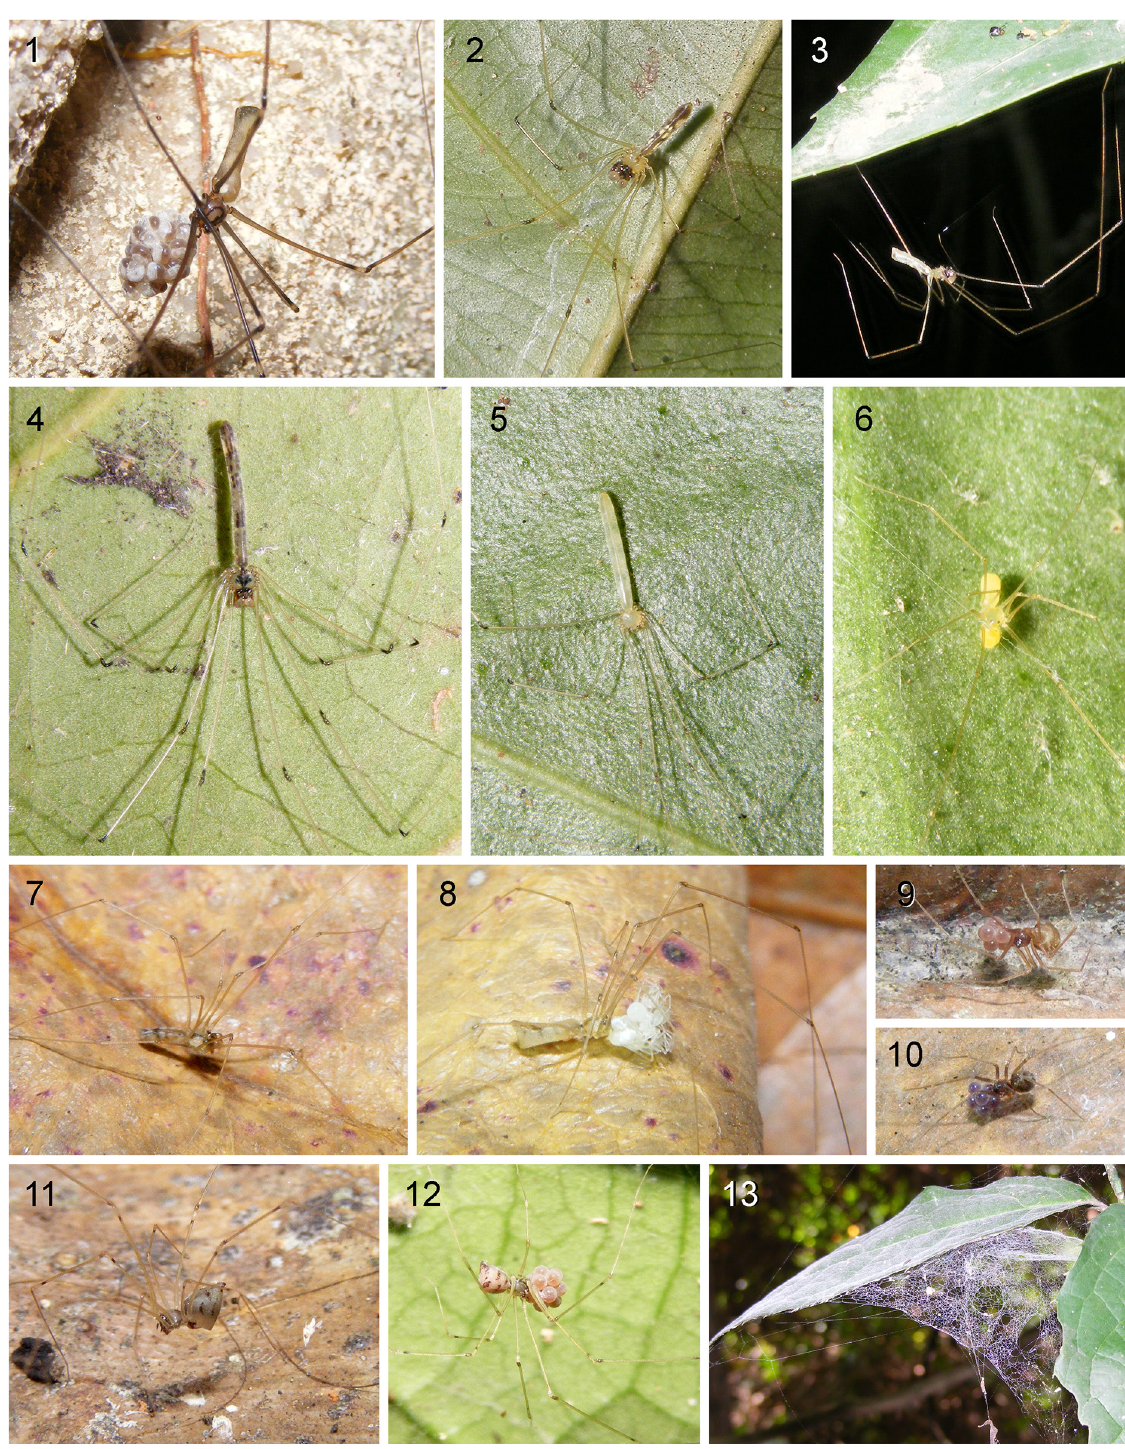
Figs 1-13. 1. Pholcus doucki Huber, 2011 from Doucki, Guinea. 2-3 . Pholcus kakum Huber, 2009 from Forêt Classée de Ziama, Guinea (2) and Kakum N.P., Ghana (3). 4 . Leptopholcus kintampo sp. nov. from Kintampo, Ghana. 5 . Leptopholcus tipula (Simon, 1907) from Kakum N.P., Ghana. 6 . Nyikoa limbe Huber, 2007 from Kakum N.P., Ghana. 7-8 . Pehrforsskalia conopyga Deeleman-Reinhold & van Harten, 2001 from Atewa, Ghana. 9-10 . Anansus atewa sp. nov. from Atewa, Ghana. 11-13 . Spermophora akwamu sp. nov. from Kakum N.P., Ghana (13: web). Photos